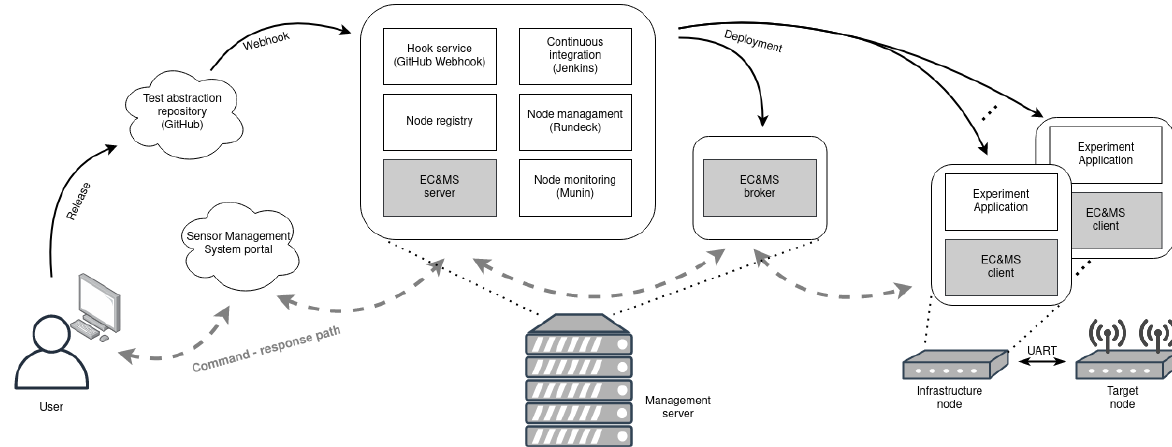
Figure 2. Continuous deployment reference